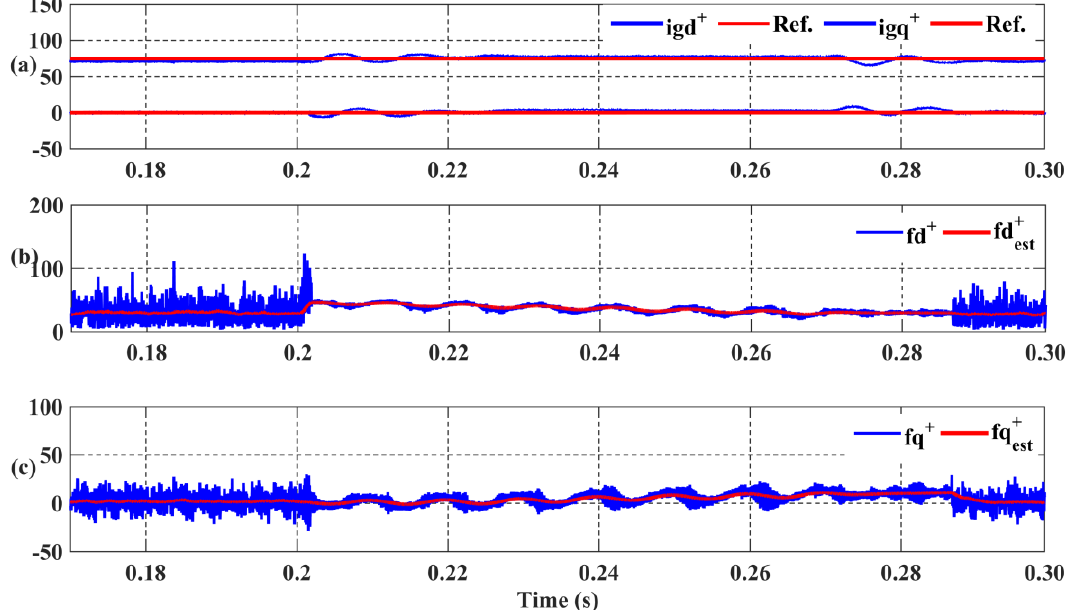
Figure 12. Simulation C results with external P ss2 -P sc2 controllers: ( a ) grid voltage (V); ( b ) grid currents (A); and ( c ) positive-sequence dq axis currents (A).